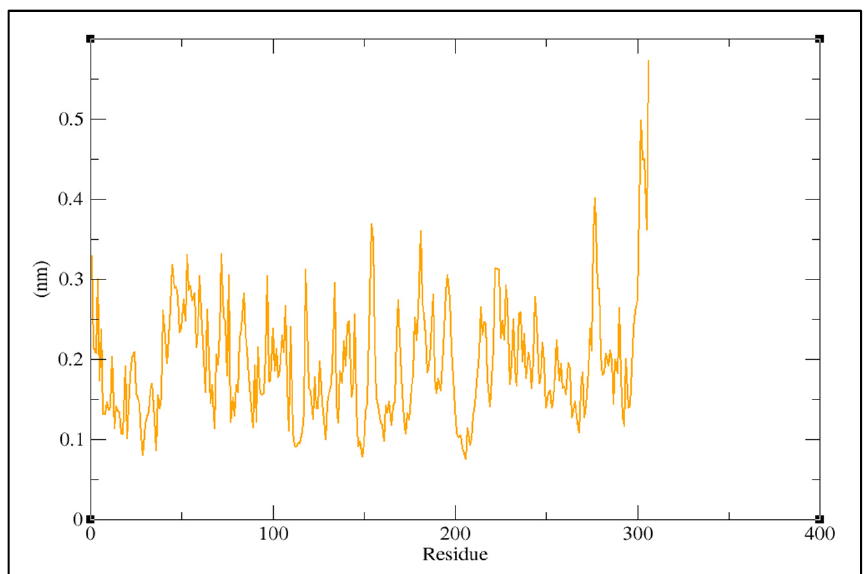
Figure 6. Molecular dynamics root mean square fluctuation (RMSF) of the protein backbone.